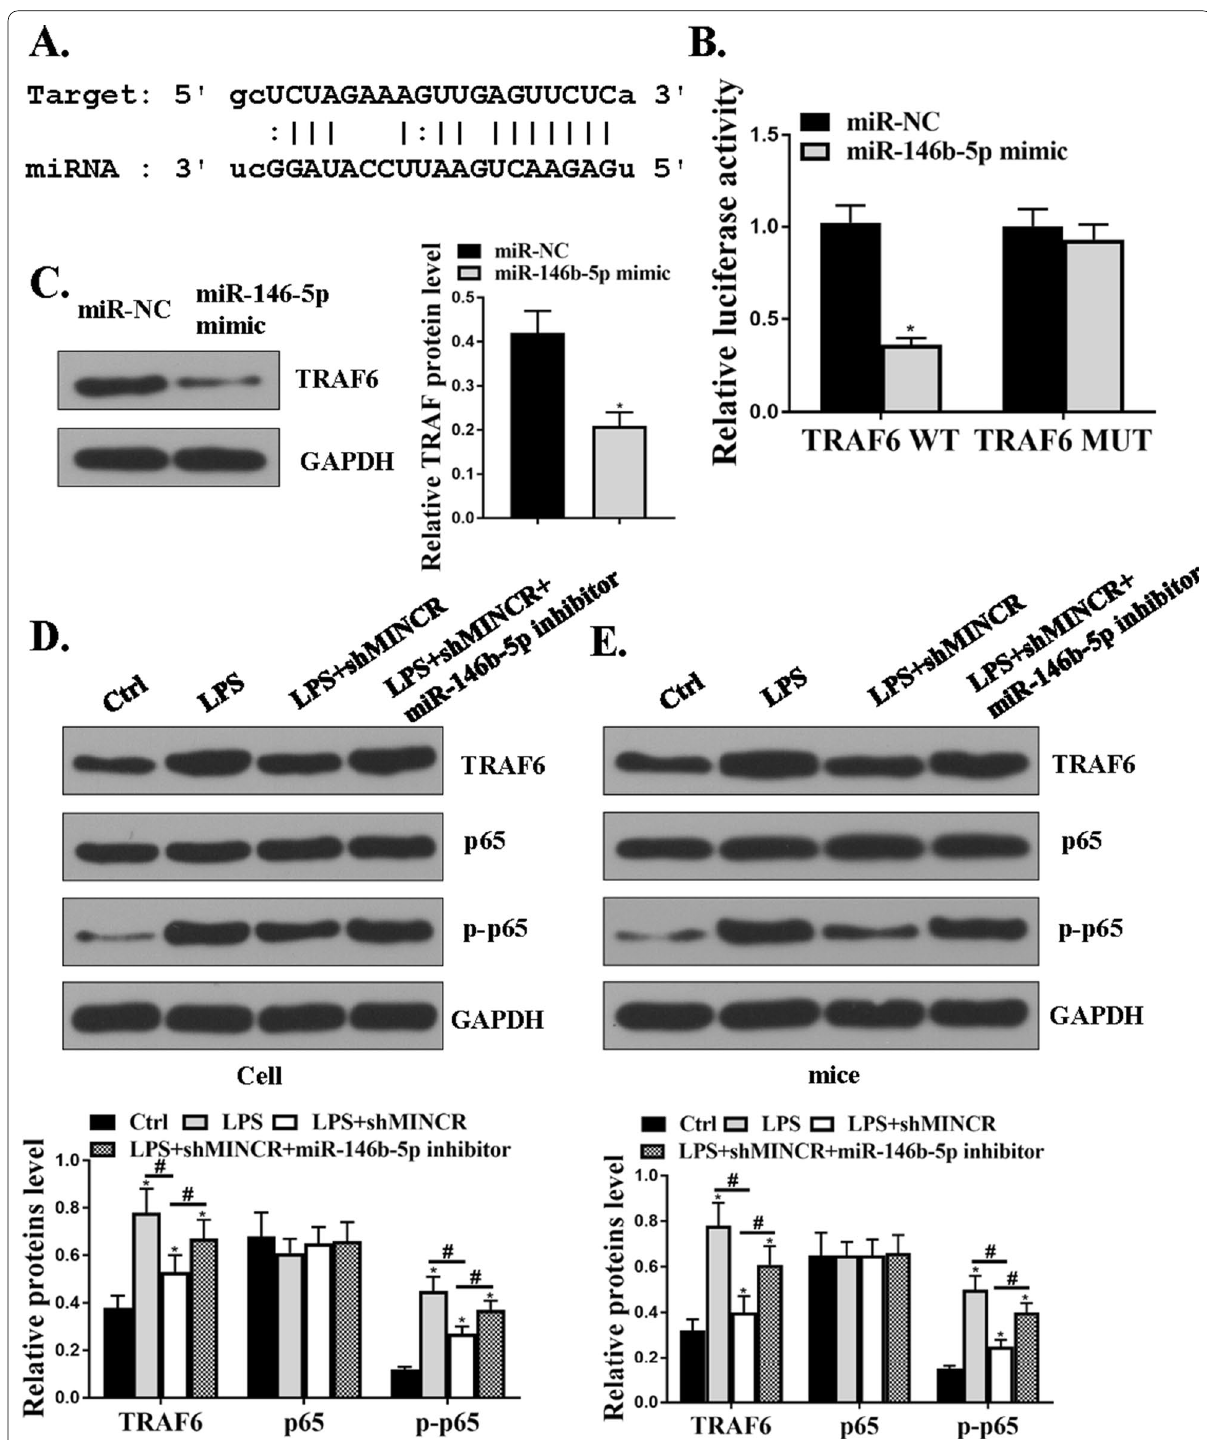
Fig. 6 MINCRT affected the progression of acute lung injury (ALI) through the miR-146b-5p/TRAF6 axis. A TRAF6 was predicted to be a target gene of miR-146b-5p. B analysis of luciferase activity in TRF6-wild type (WT) or TRAF6-Mut vector co-transfected cells. C protein expression levels of TRAF6 in small airway epithelial cells (SAECs). D protein expression levels of TRAF6, P65, and p-P65 in SAECs was detected by Western blotting assay. E protein levels of TRAF6, p65, and p-P65 in lung tissue treated with lipopolysaccharide (LPS) was detected by Western blotting assay. * P < 0.05, N